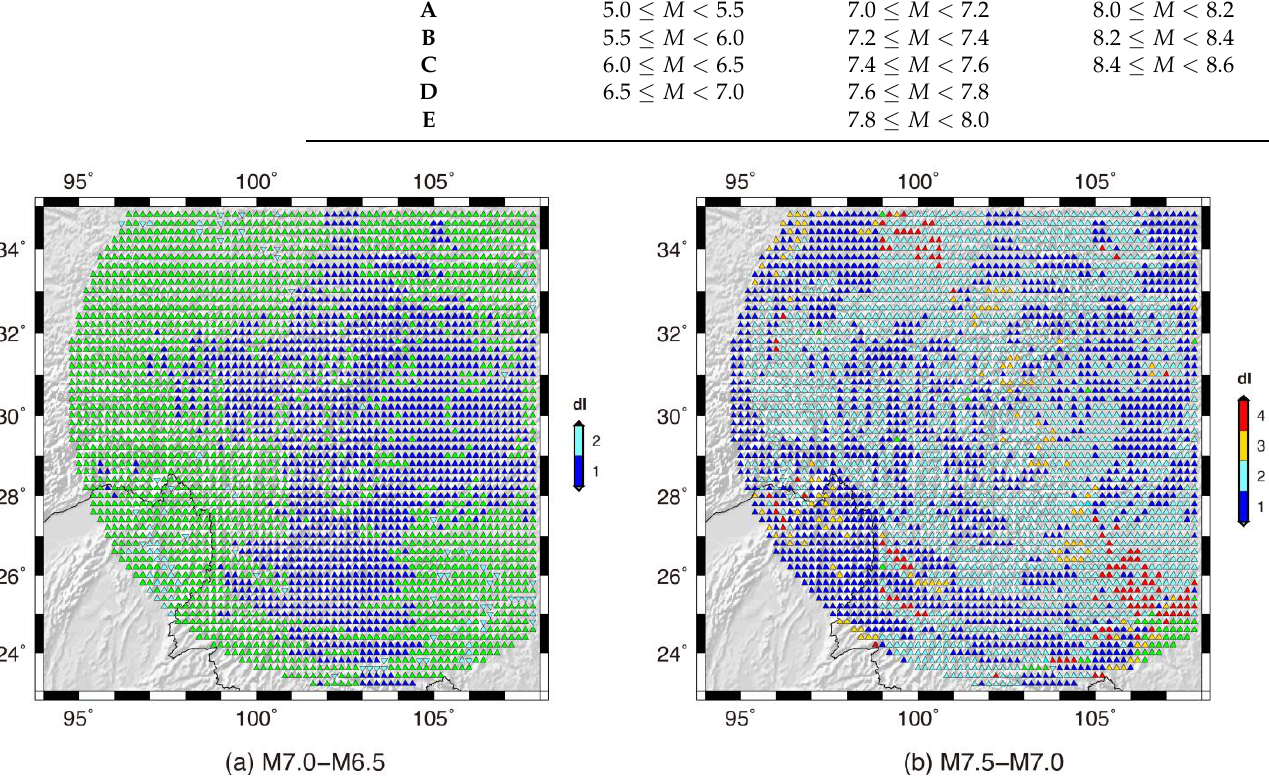
Figure 4. The differences of MMI values obtained considering computations of four scenarios with varying magnitude values (magnitude step is equal to 0.5) whereas the other focal parameters are fixed. Distribution of differences between ( a ) magnitude 7 and 6.5, and ( b ) magnitude 7.5 and 7.0 scenario computations. The green triangles indicate the different is zero.